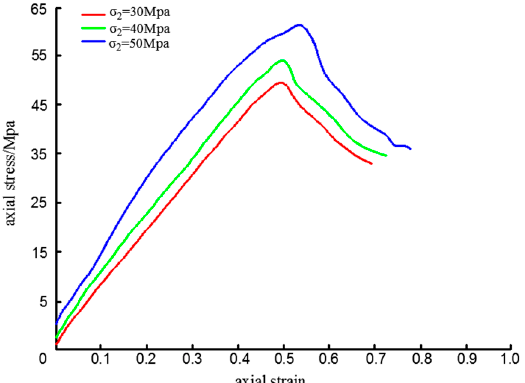
Figure 5. Stress-strain curves of specimens with different intermediate principal stresses.